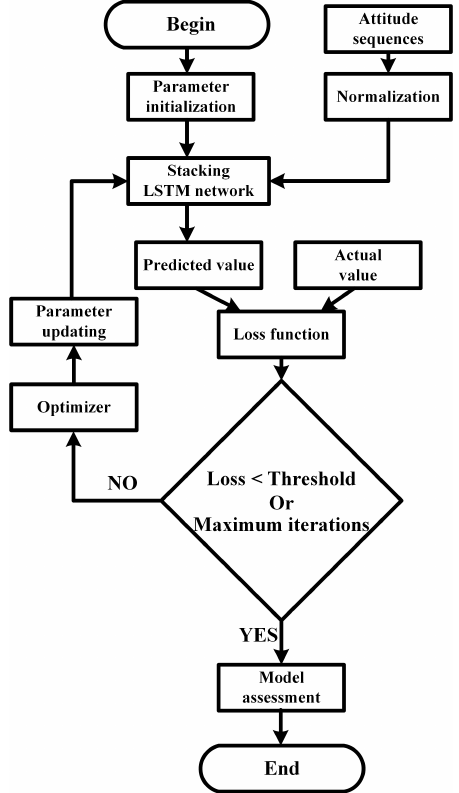
Figure 6. The training process of the 1D CNN-LSTM neural